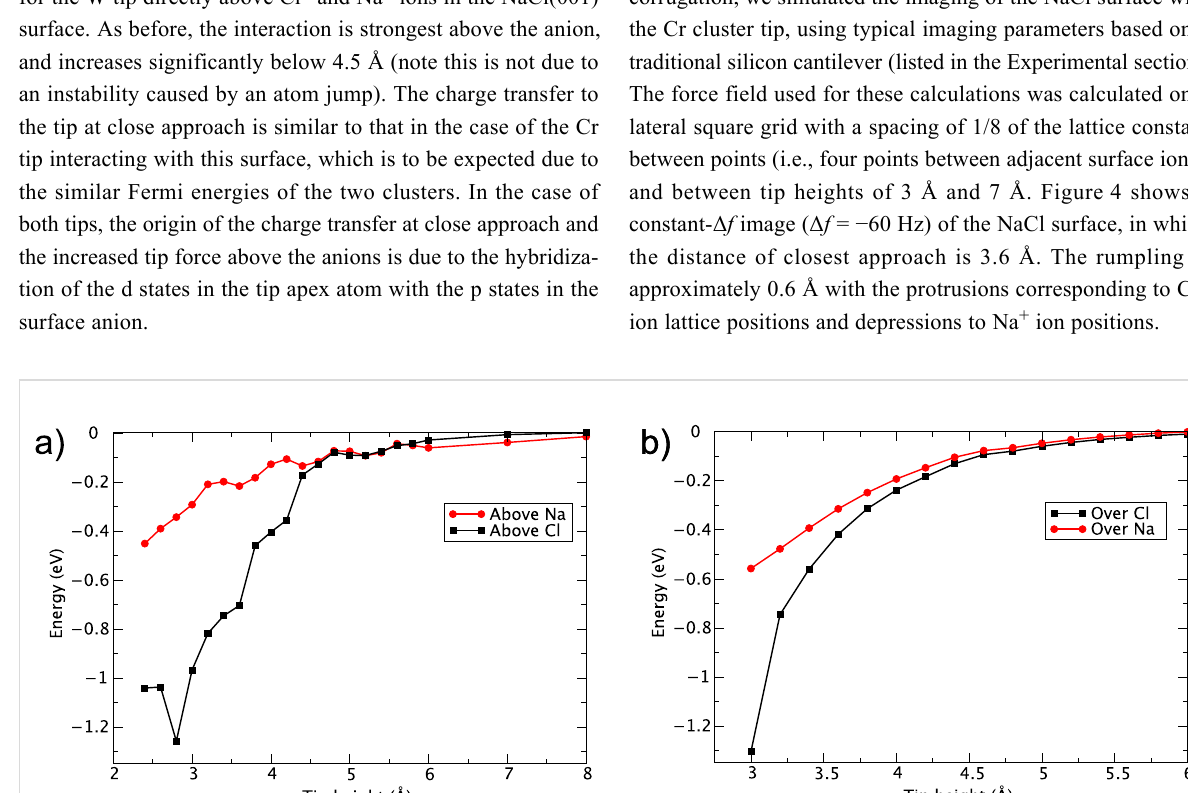
Figure 2: (a) Energy as a function of cluster Cr tip height above the NaCl(001) surface. (b) Energy as a function of tip height above the MgO(001) surface.